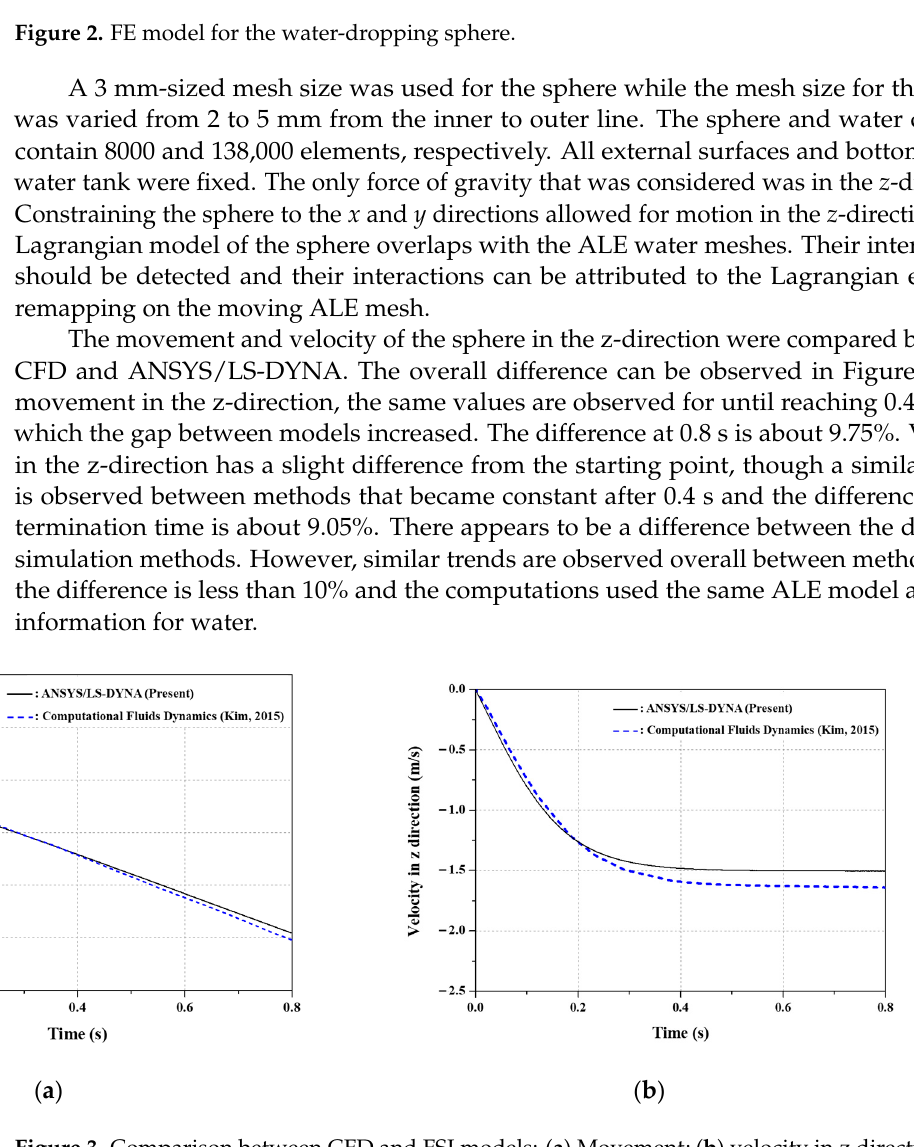
Figure 3. Comparison between CFD and FSI models: ( a ) Movement; ( b ) velocity in z direction.